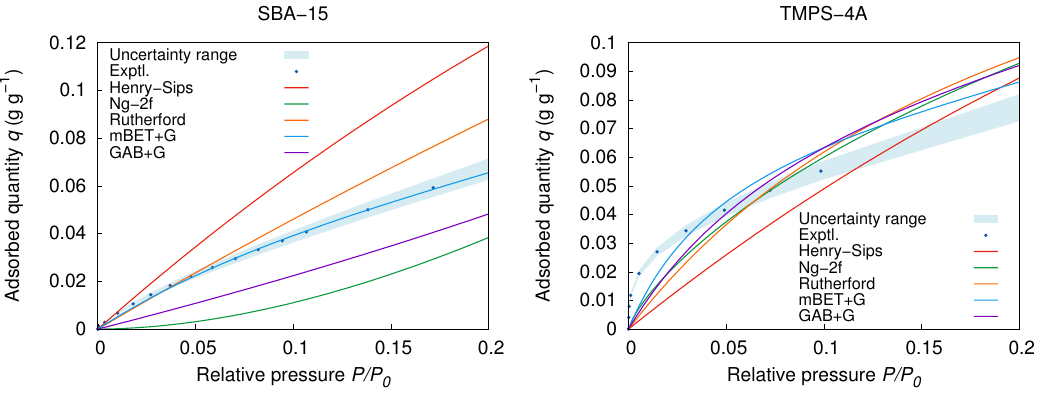
Figure 5. Detailed view on the models fitting at low P / P 0 (TMPS-4A: 25 ◦ C, SBA-15: 20 ◦